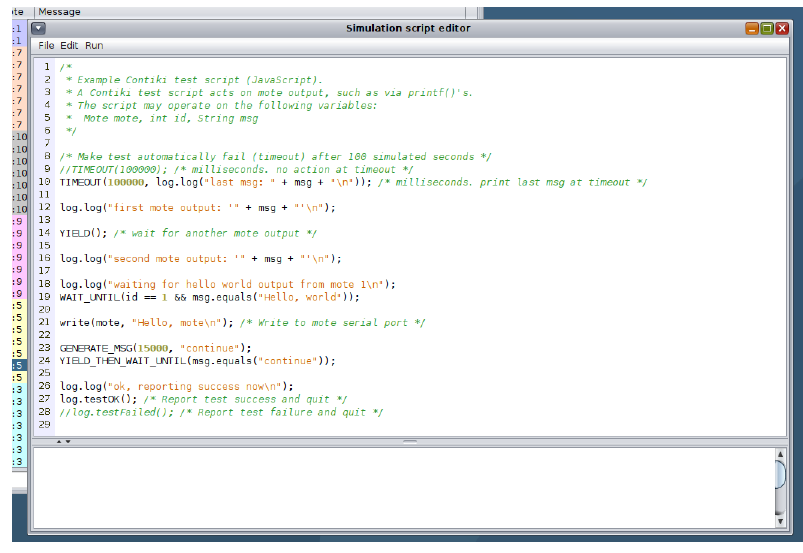
Figure 8. Simulation Script Editor with example JavaScript